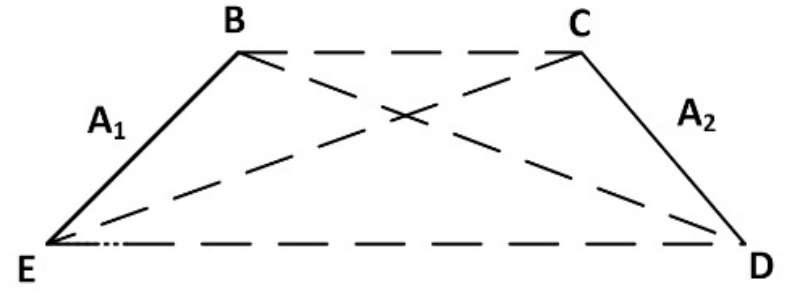
Figure 1. View factor of surface A 1 to surface A 2 and surface A 2 to sky BC